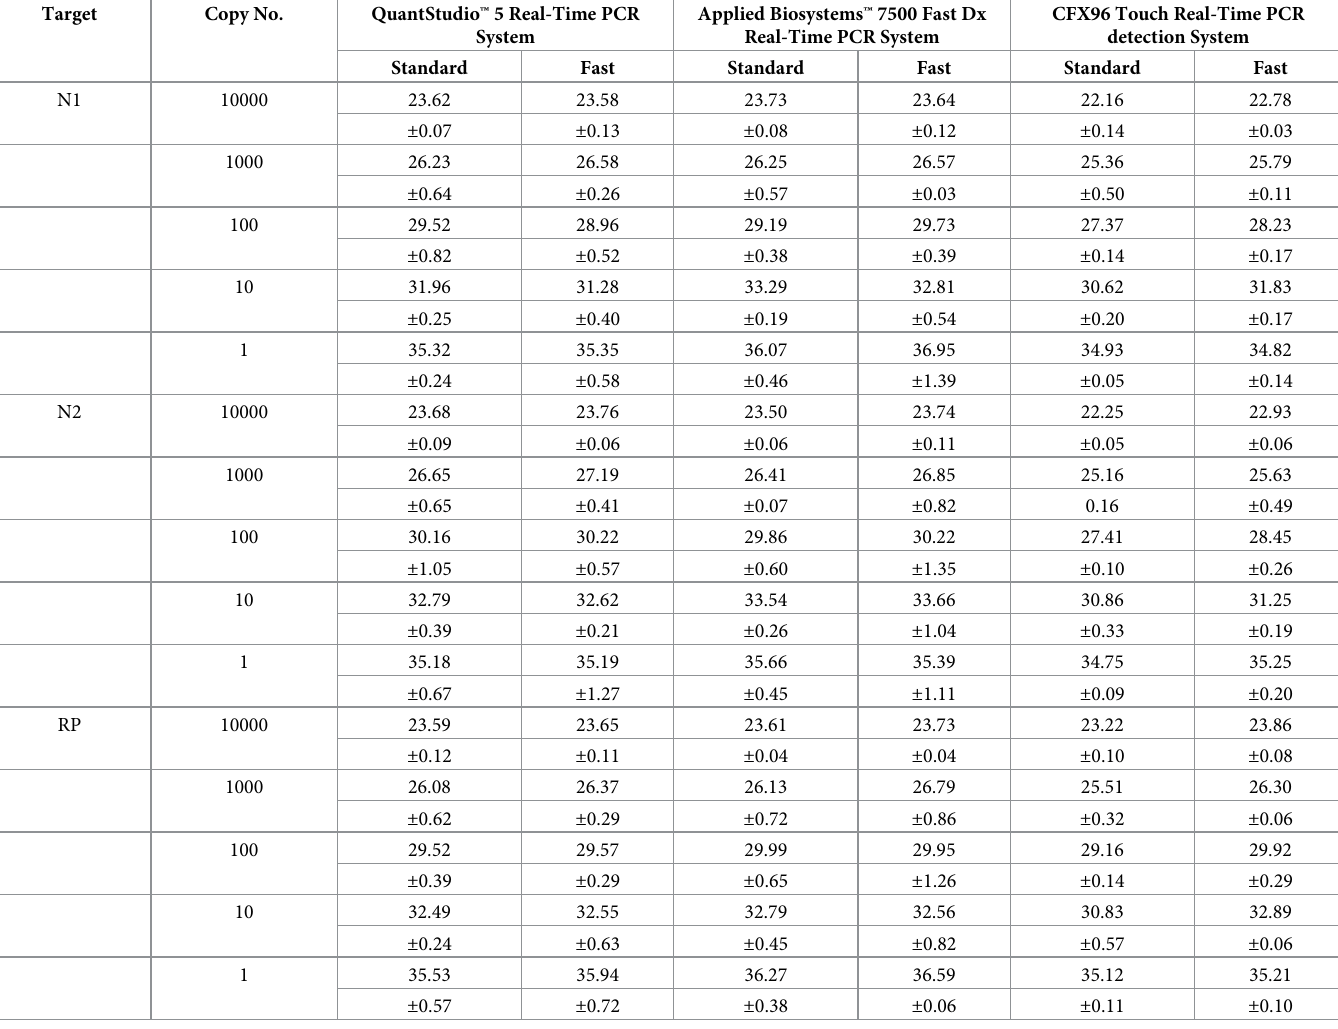
Table 2. Ct values of standard and Fast PCR-based amplification products namely N1, N2 of SARS-COV-2 & synthetic version of human RNase P, an internal control. Target Copy